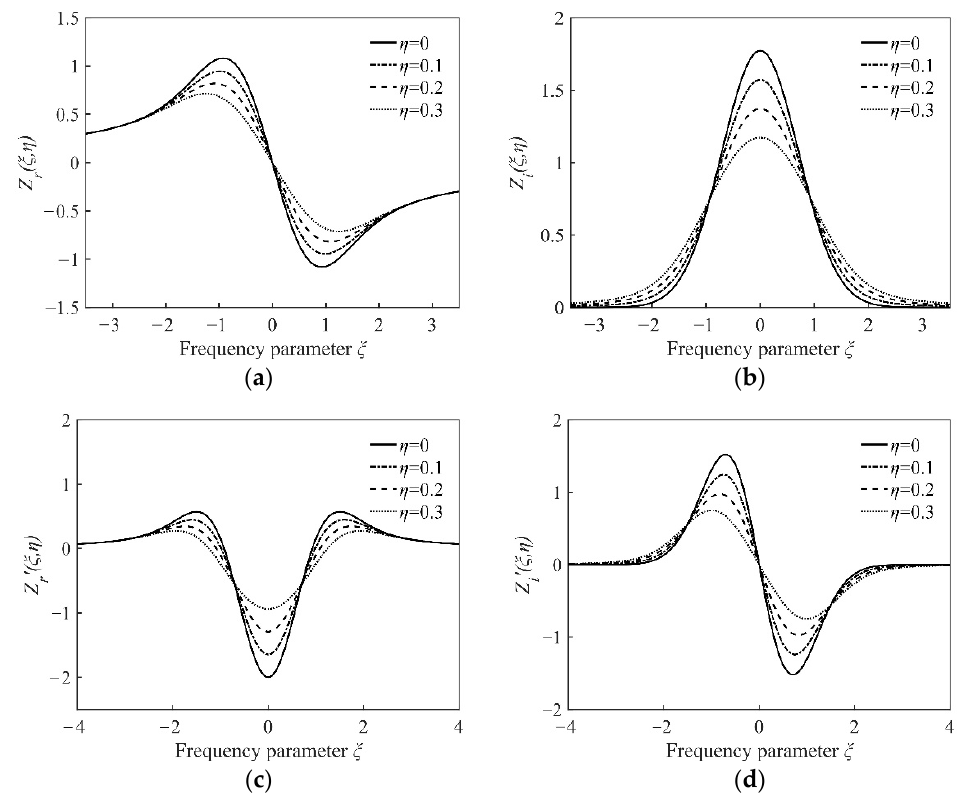
Figure 2. Numerical results of the plasma dispersion function. ( a ) The real part of the plasma dispersion function; ( b ) the imaginary part of the plasma dispersion function; ( c ) the first derivative of the plasma dispersion function’s real part; ( d ) the first derivative of the plasma dispersion function’s imaginary part.